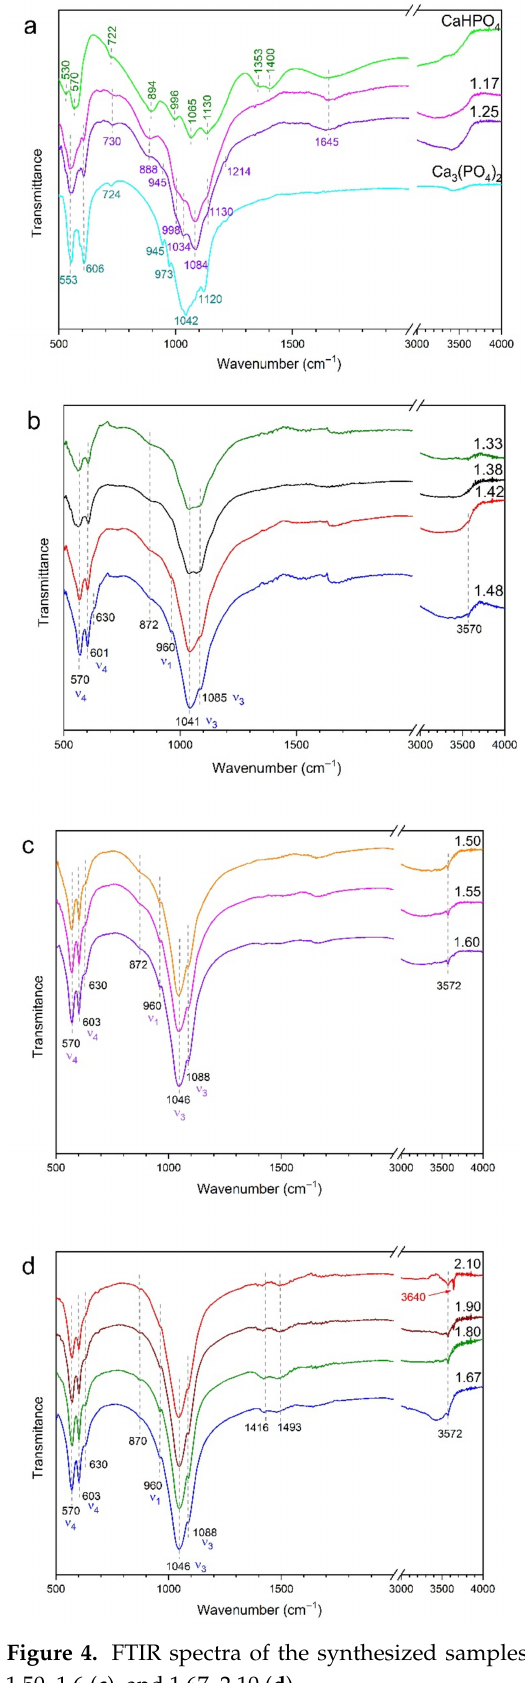
Figure 4. FTIR spectra of the synthesized samples with Ca/P ratios 1.17–1.25 ( a ), 1.33–1.48 ( b ), 1.50–1.6 ( c ), and 1.67–2.10 ( d